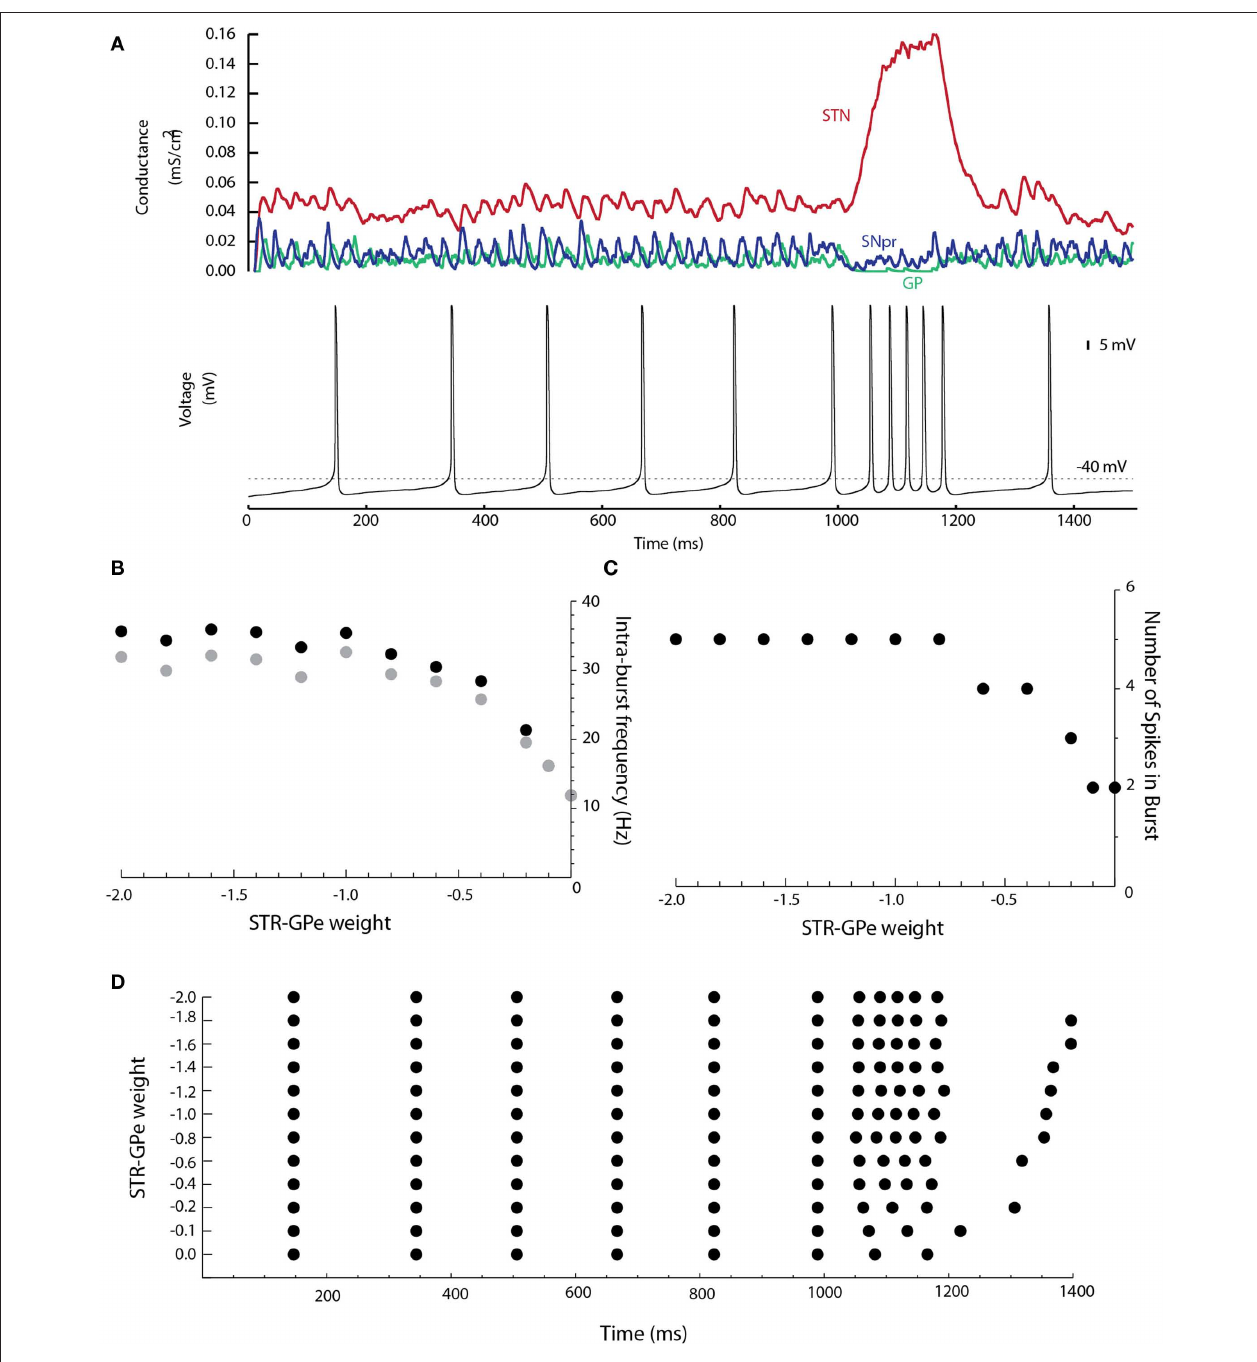
black, mean gray) as a function of the D1STR–GP weight. (C) Shows the number of spikes in the burst. A raster plot of the results is shown in (D) . To avoid ceiling effects, in these simulations δ was reduced to δ = 0.0043 ms/cm 2 and GABA = 0.0030 ms/cm 2 so that the mean tonic conductances were δ NMDA approximately g = 0.02 ms/cm 2 and g = 0.04 ms/cm 2 GABAA NMDA